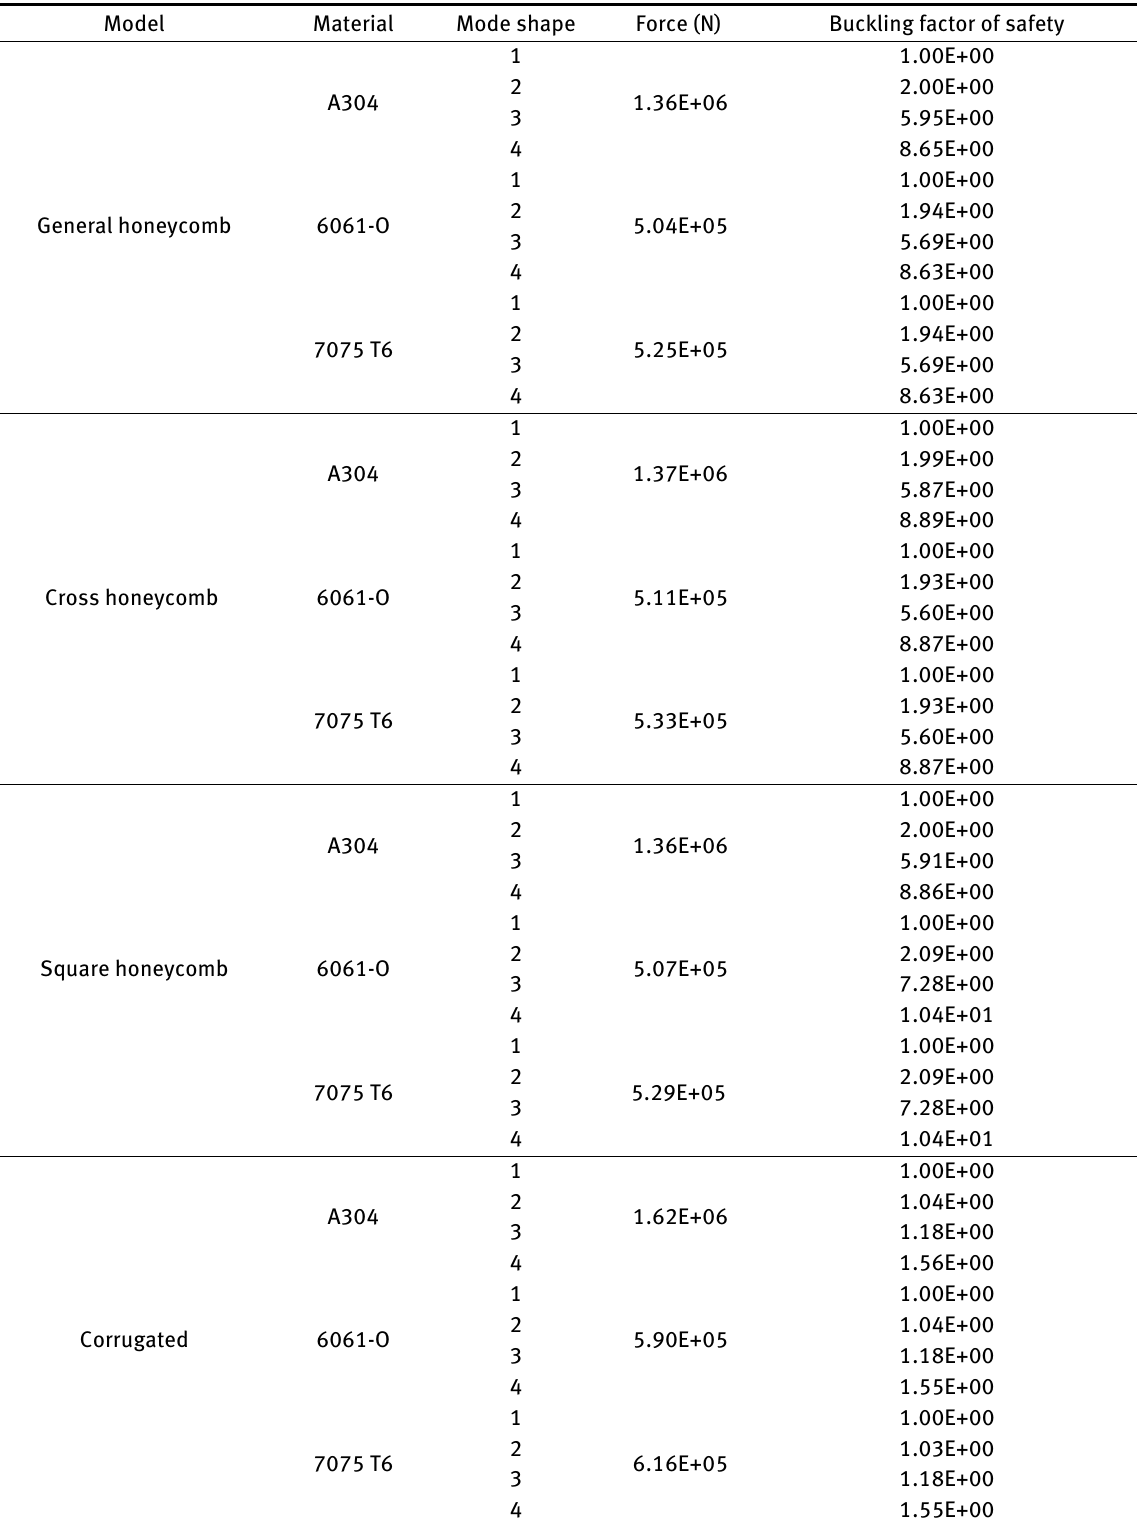
Table 12: Summary of the results for the buckling factor of